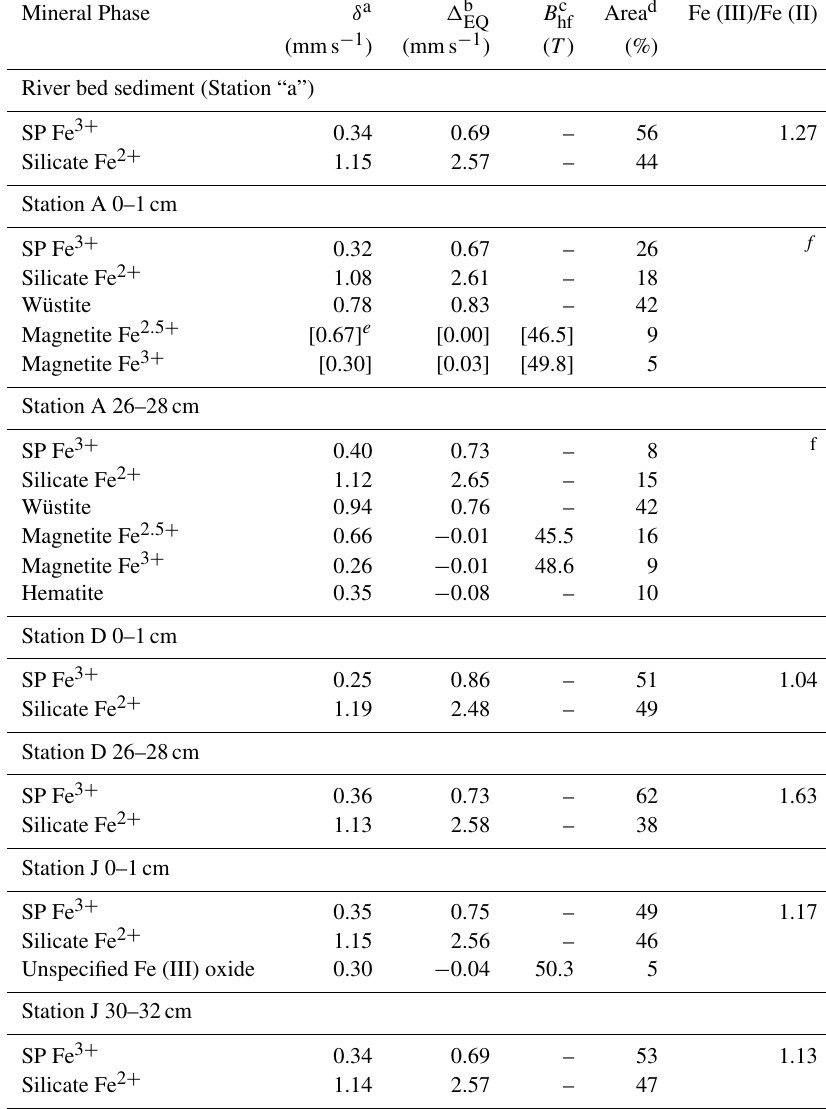
Table 4. Mössbauer parameters corresponding to spectra in Figs. 7 and Fig.